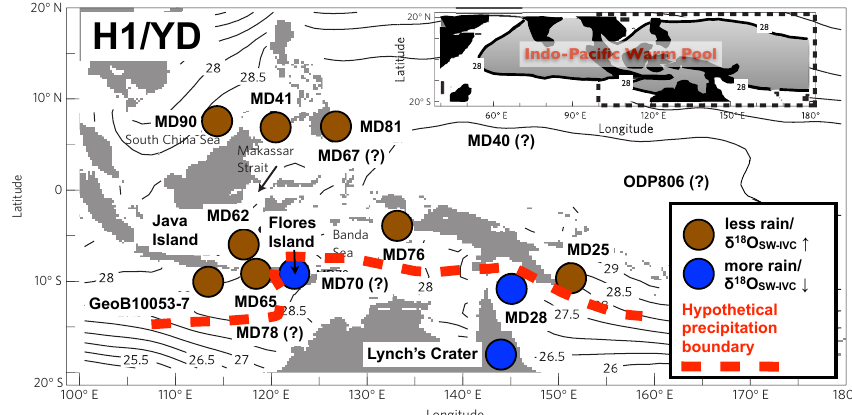
Figure 6. Hypothetical proxy-inferred precipitation boundary during the H1 and YD events (modified from the Linsley et al., 2010). Blue dots represent a relatively increasing precipitation/ δ 18 O SW lighter condition, and brown dots a decreasing precipitation/ δ 18 O SW heavier condition. The segment between the Java and Flores islands of this sharp boundary (red dashed line) was proposed by Mohtadi et al. (2011), and the one between the Solomon and Coral seas by this study. Black contours represent